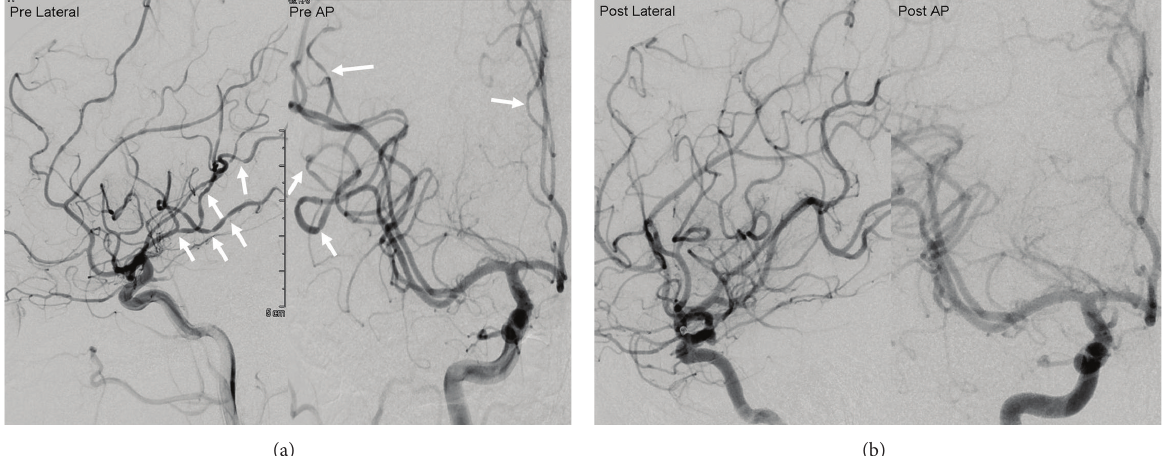
Figure 2: (a) Admission DSA of the right ICA shows multivessel vasoconstrictions. (b) Three-month follow-up DSA of the right ICA shows reversal of the diffuse vasoconstrictions. DSA: digital subtraction angiography. ICA: Internal carotid